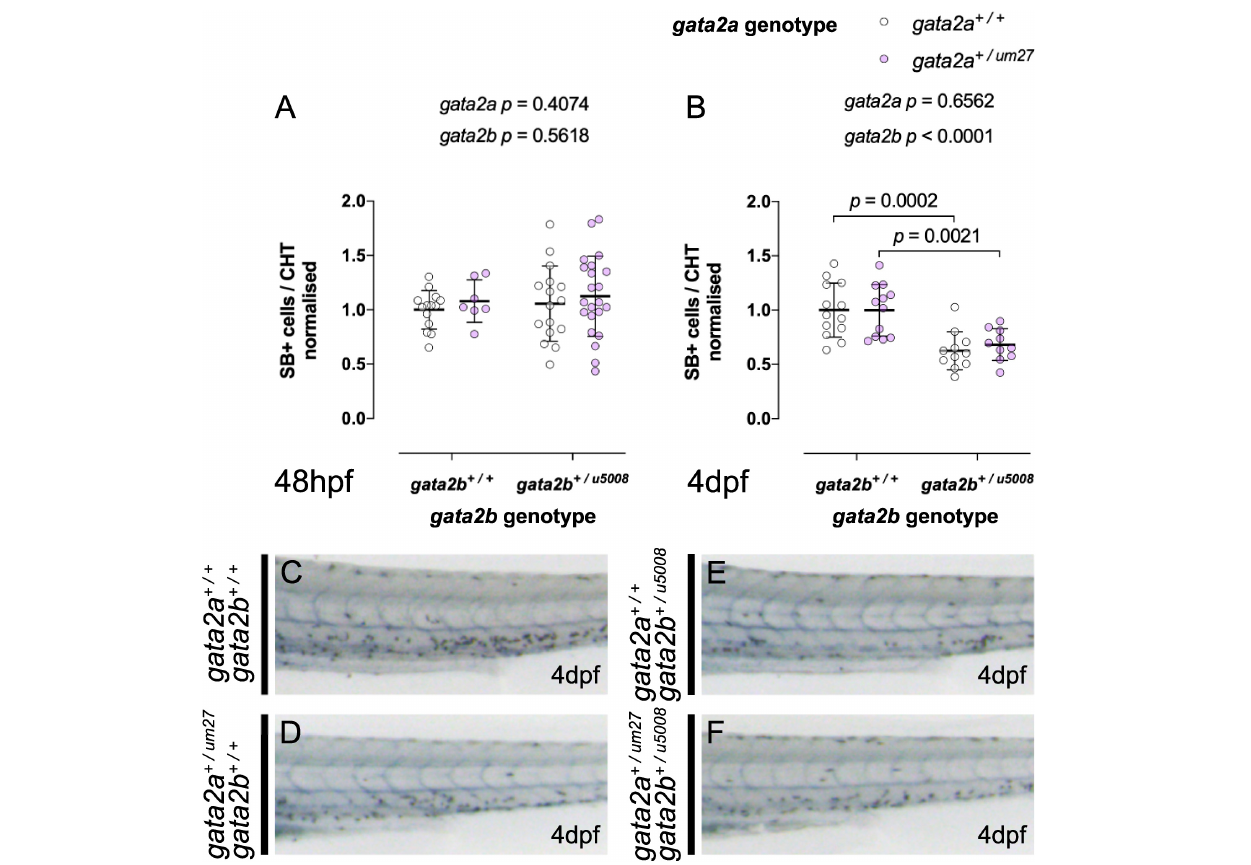
FIGURE 5 | Gata2b + / u 5008 mutants display impaired definitive granulopoiesis independent of gata2a genotype. (A,B) Quantifications of SB+ cells in the CHT of 48 hpf (A) and 4 dpf (B) fish from a Gata2a + / um 27 to Gata2b + / u 5008 cross. (C–F) Lateral views of the trunk of SB stained larvae at 4 dpf showing decreased SB+ cells in the CHT of Gata2b + / u 5008